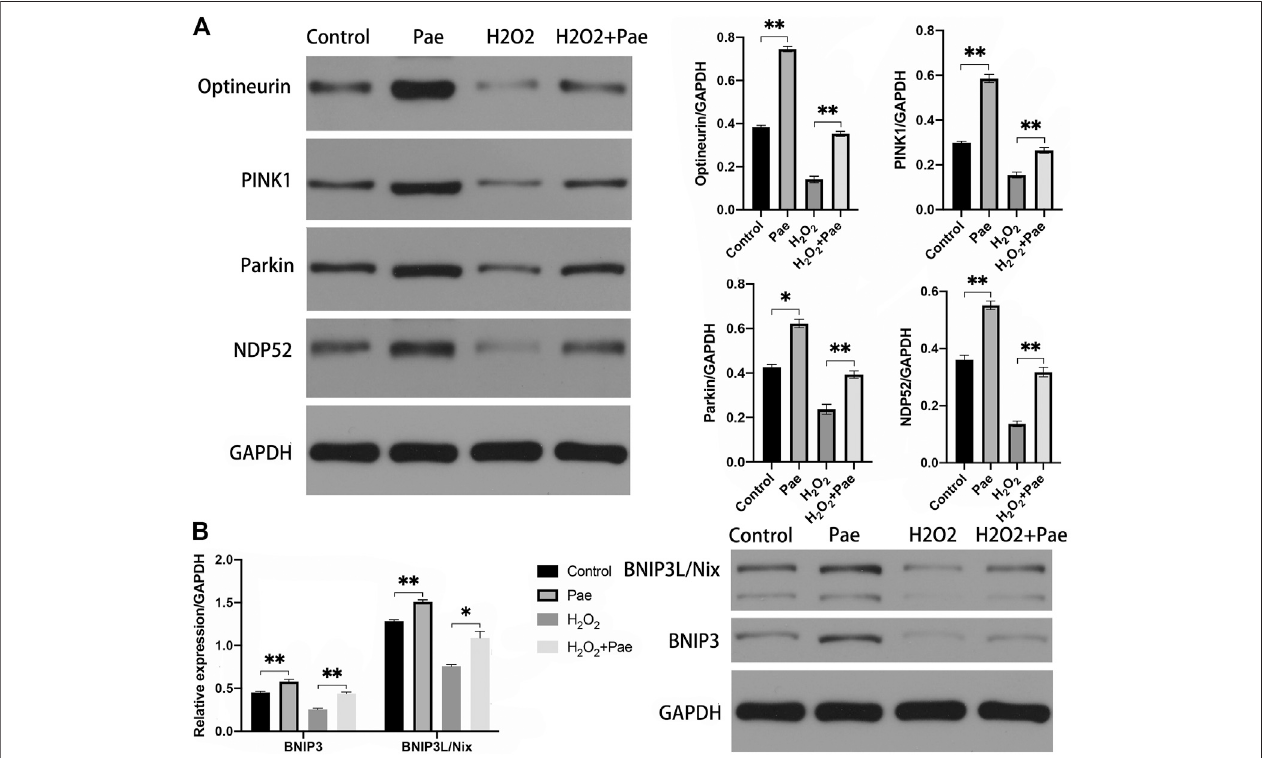
FIGURE 7 | Pae activated mitophagy via the PINK1/Parkin dependent and the BNIP3L/Nix dependent pathways in 661W cells. (A) The expression of proteins associated with the classic INK1/Parkin dependent pathway of mitophagy was measured by Western blot analysis as well as (B) the expressed level of proteins of the BNIP3L/Nix dependent pathway of mitophagy. GAPDH, as loading control were reused from Figure.6. Data show mean ± SD. ( n (cid:1) 6 – 9 for each group) * p < 0.05, ** p < 0.01.